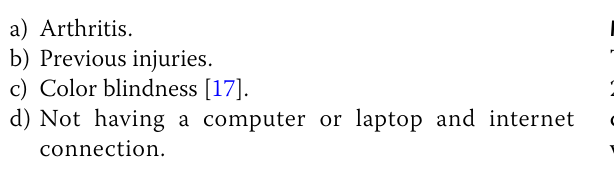
Table 2 ADHD and Stroop effect correlation